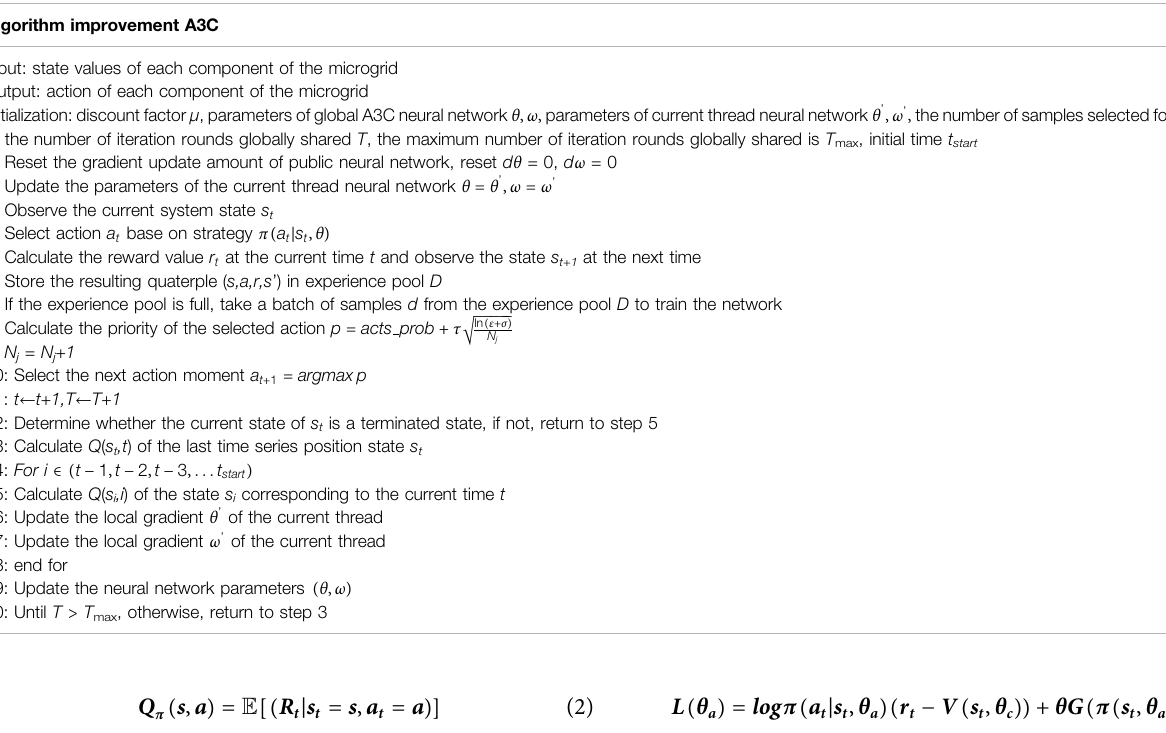
TABLE 1 | The details of UCB-A3C algorithm is described. Algorithm improvement